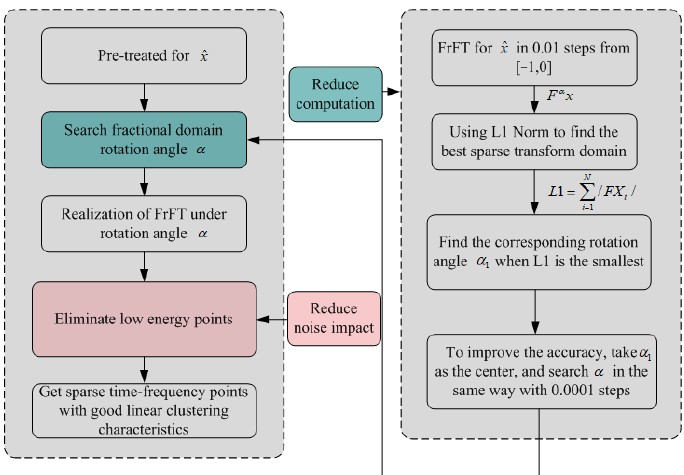
Figure 2. Flow chart for searching α of